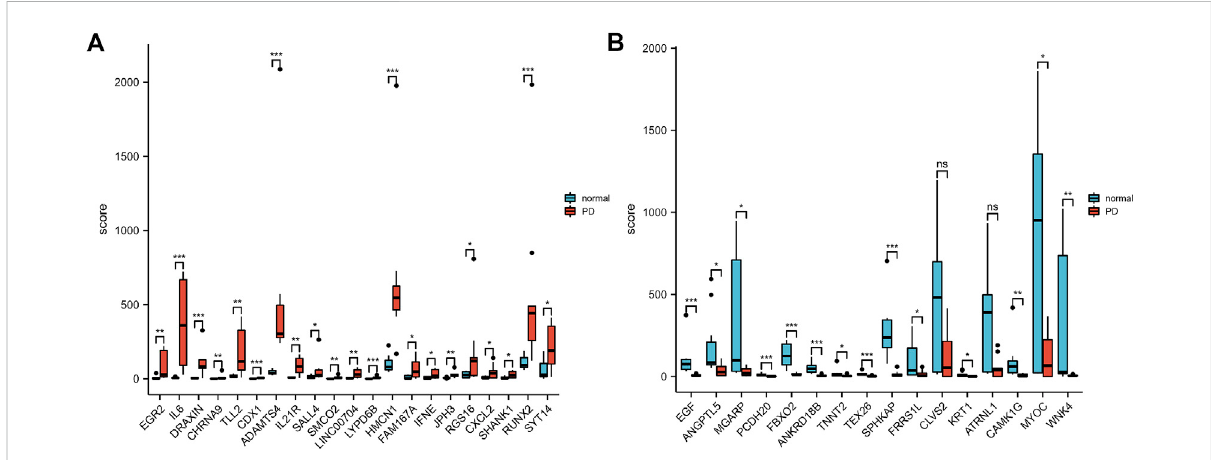
PD were EGR2, IL6, DRAXIN, CHRNA9, and TLL2, and the top fi ve hub genes suppressed in PD were KRT1,